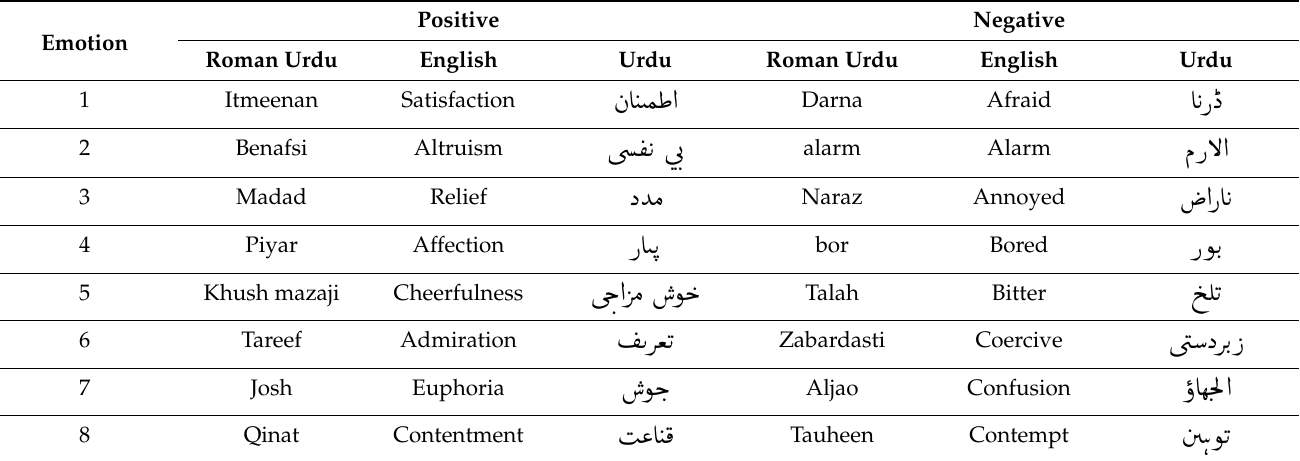
Table 6. Positive and Negative Keywords Sample for Sentiment